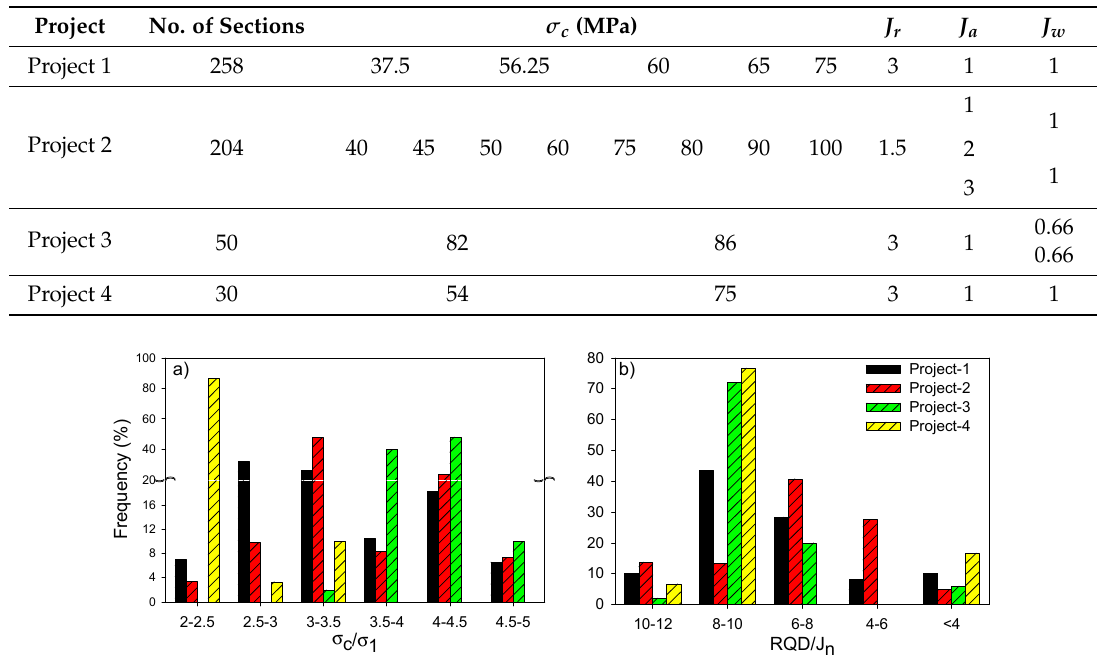
Table 3. Q -system parameters for the first four projects, and the tunnel spans.